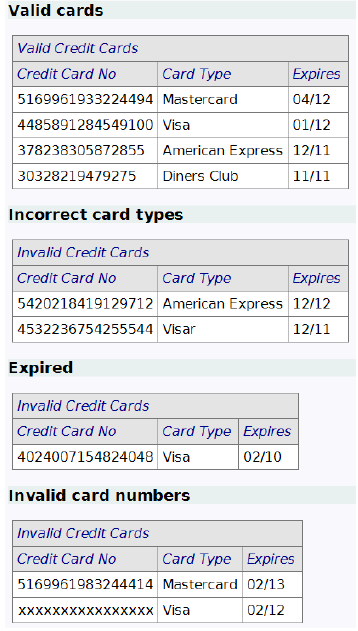
Figure 2. A business-level